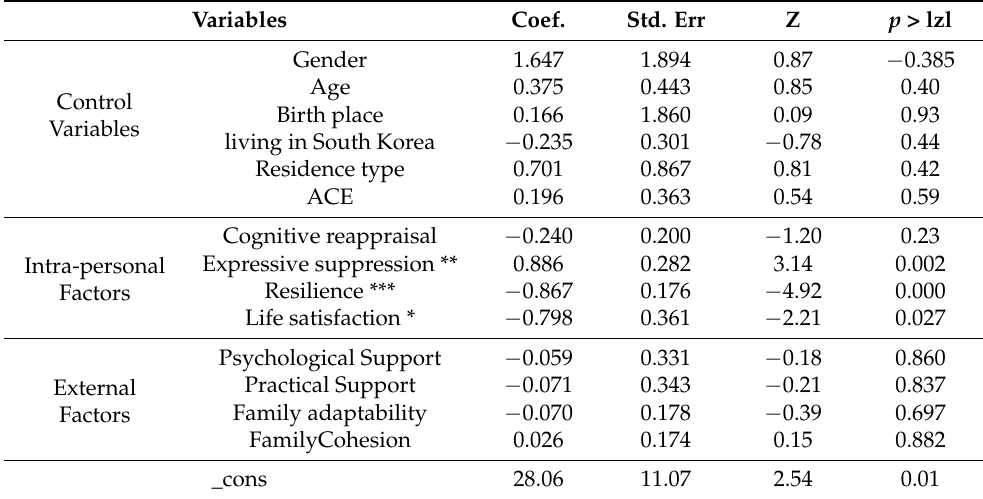
Table 3. The result of random-effects GLS